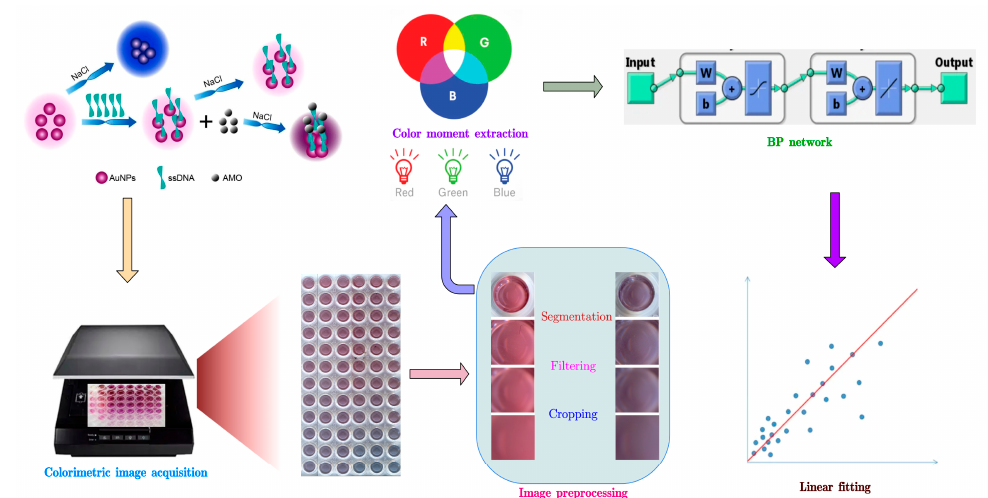
Scheme 1. Schematic illustration of the detection of amoxicillin in breast milk. When different concentrations of amoxicillin were bound to AuNPs-ssDNA, different color reactions were produced. The results were captured by portable image acquisition equipment and processed by artificial intelligence algorithms.